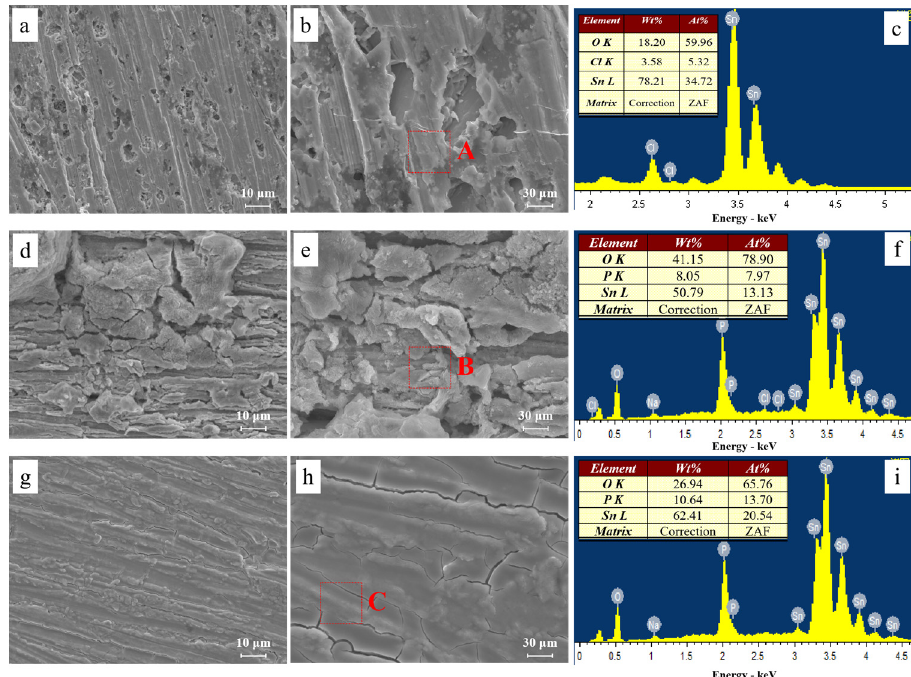
Figure 10. SEM images and corresponding EDS results of precipitates formed after ECM tests of tin under a droplet of 15 µ L containing various concentrations of Na 2 HPO 4 at 3 V: ( a ) 0 mg / L; ( b ) enlarged image of image ( a ); ( c ) EDS results of section A; ( d ) 500 mg / L; ( e ) enlarged image of image ( d ); ( f ) EDS results of section B; ( g ) 1000 mg / L; ( h ) enlarged image of image ( g ); ( i ) EDS results of section C.